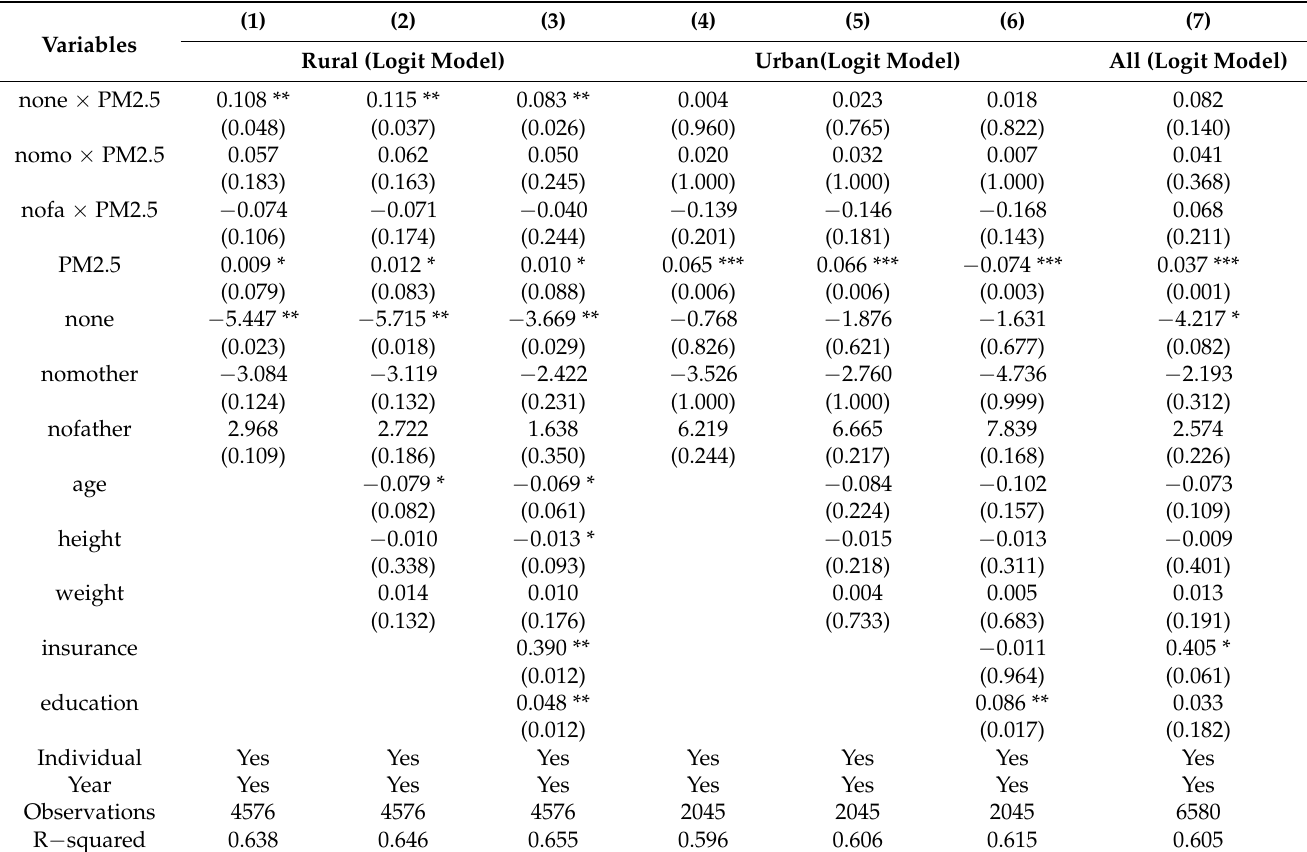
Table 2. Basic regression results of haze pollution and the health of left-behind